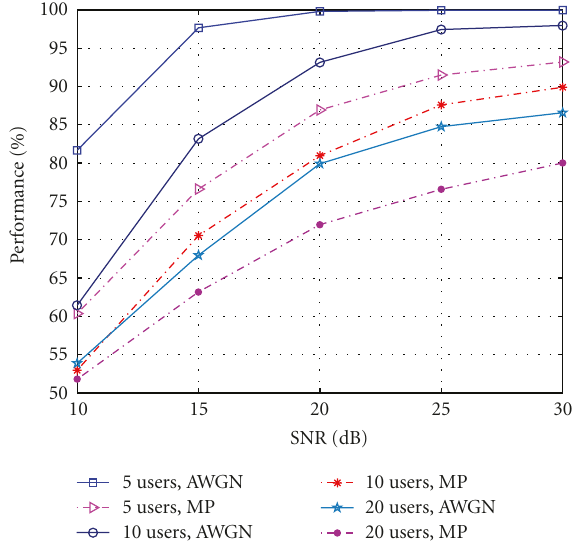
Figure 8: Performances in separating the user subcarriers in AWGN and MP channels for various numbers of